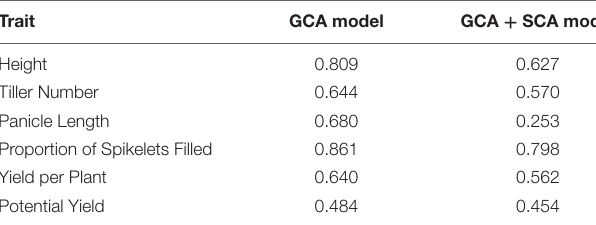
TABLE 6 | Accuracies of phenotypic selection for male GCA.